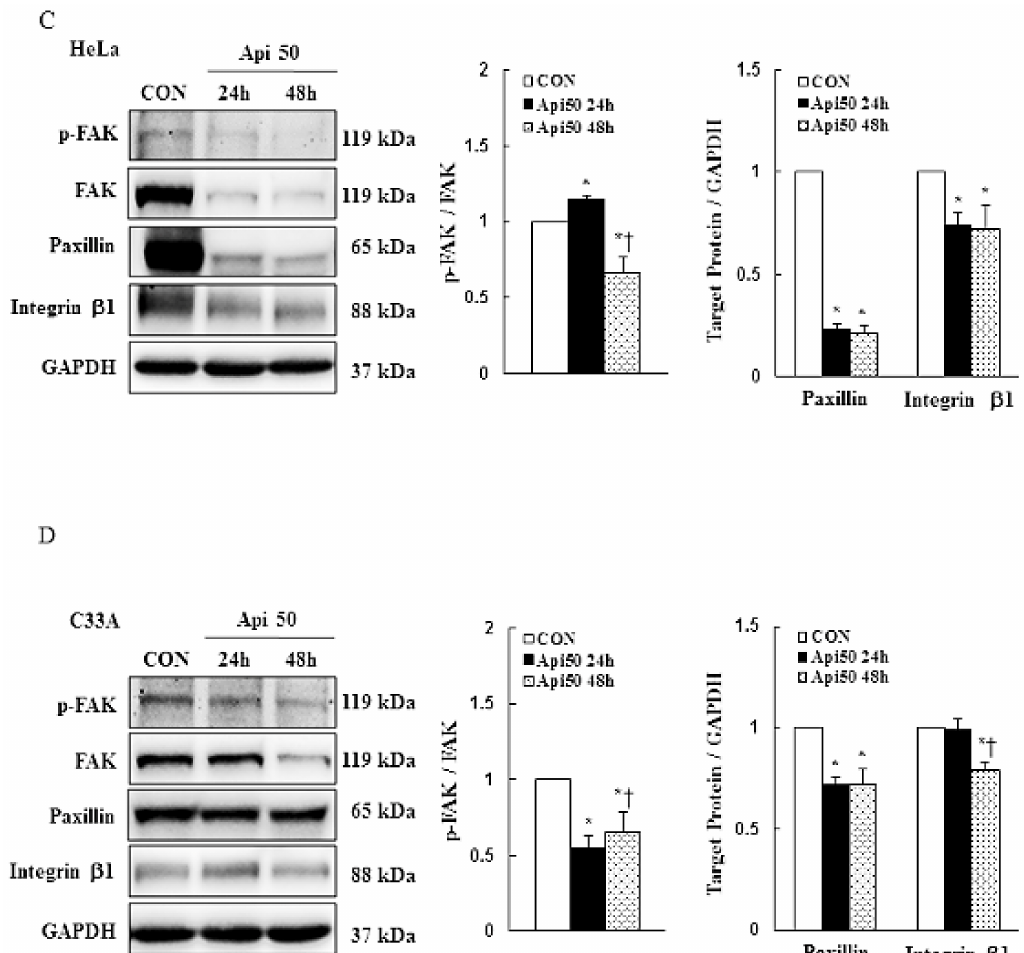
Figure 4. Apigenin inhibits cancer cell migration and inactivates the integrin β 1-FAK signaling pathway. Wound-healing assays were performed with or without 50–100 µ M apigenin in HeLa ( A ) and C33A ( B ) cells for 0, 24, and 48 h. Left: representative images of scratches and recovery of wounded areas on cell monolayers at 0, 24, and 48 h after wounding. Right: semi-quantitative analysis of relative cell migration was performed according to the cells moving towards the scratched area at a certain time. Cell migration-related proteins p-FAK, paxillin, and integrin β 1 were detected in HeLa ( C ) and C33A ( D ) cells with or without 50 µ M apigenin treatment for 24 and 48 h via Western blotting and quantified. Data are presented as the mean ± SD of at least three independent experiments. * and † p < 0.05 indicate significant differences as compared with the corresponding control or Api 50-treated groups. CON, 0.1% DMSO; Api 50, 50 µ M apigenin; Api 100, 100 µ M apigenin; Api50 24 h, 50 µ M apigenin at 24 h; Api50 48 h, 50 µ M apigenin at 48